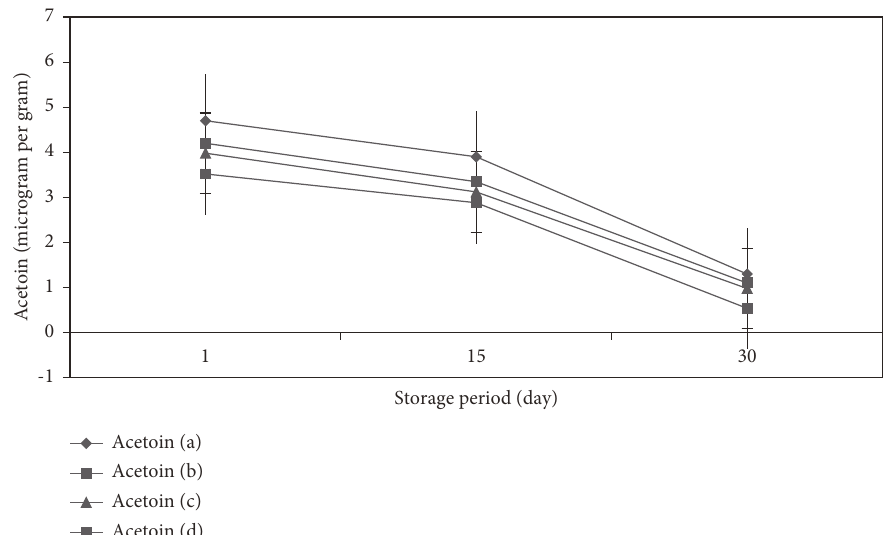
Figure 6: Changes in ethanol ∗∗ ( µ g/g) during storage of Iranian UF cheese ∗ treated by KCl and NaCl during 30 days of storage period. ∗ (a) 3% NaCl (control), (b) 1.50% NaCl+1.50% KCl, (c) 1.00% NaCl+2.00% KCl, and (d) 0.75% NaCl+2.25% KCl. ∗∗ means at the same age differed significantly ( P > 0 . 05).